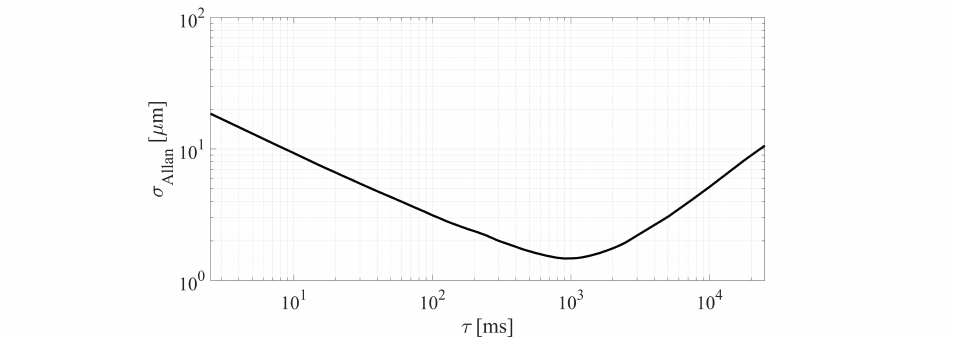
Figure 12. Allan Deviations as a function of observation time for the static indoor